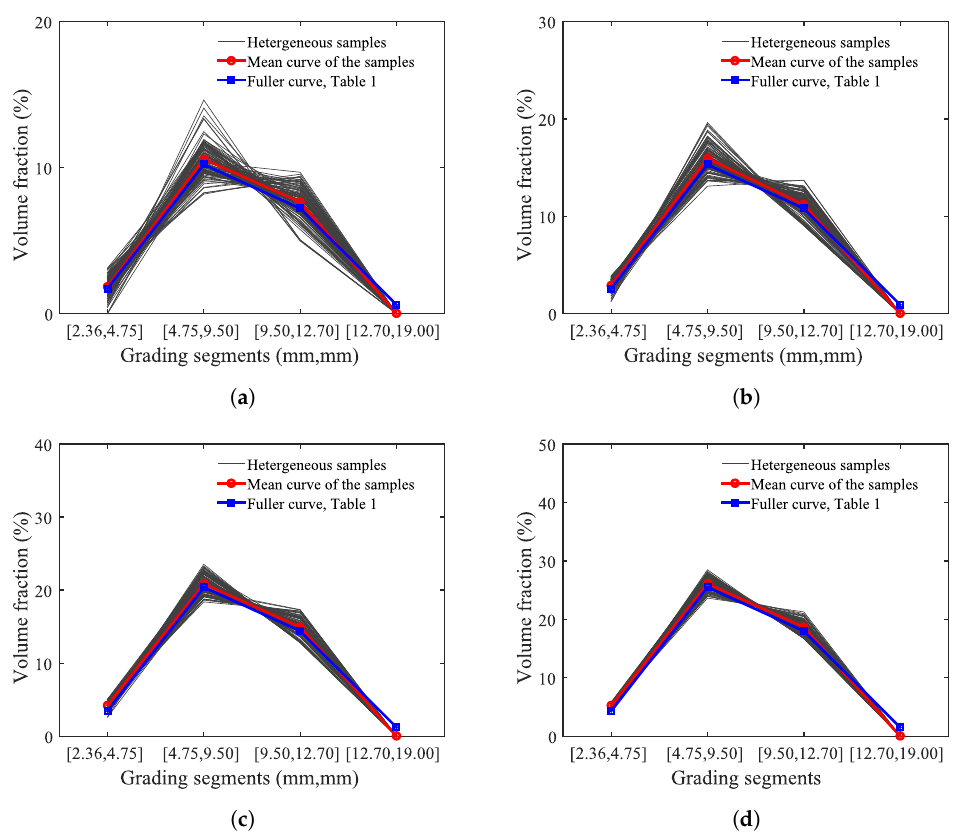
Figure 3. Aggregate gradations achieved by simulation versus the Fuller curve. ( a ) P agg = 20%; ( b ) P agg = 30%; ( c ) P agg = 40%; ( d ) P agg =